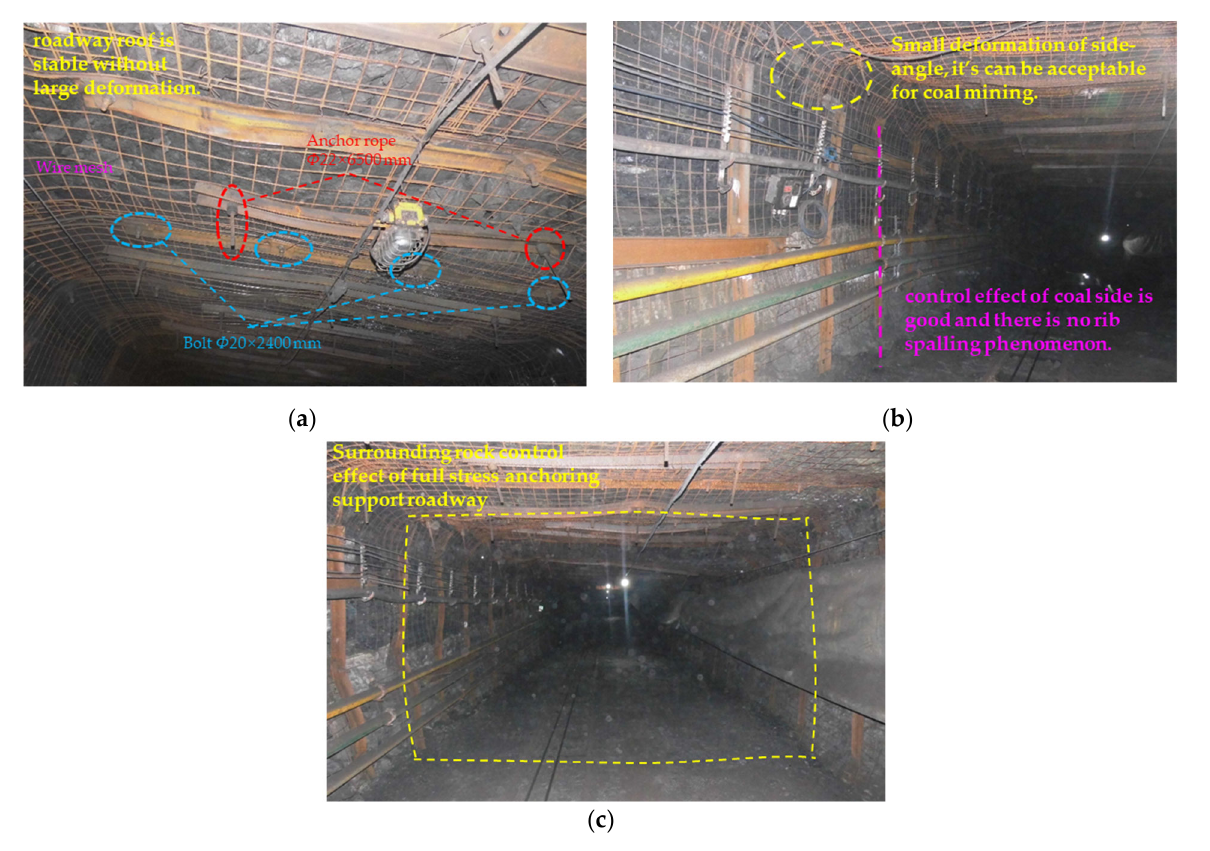
Figure 16. Application of full ‐ stress anchoring support in the return airway. ( a ) Support effect of roof; ( b ) Side ‐ angle and coal side control effect; ( c ) Full ‐ stress anchoring of bolt in a full section mining roadway.